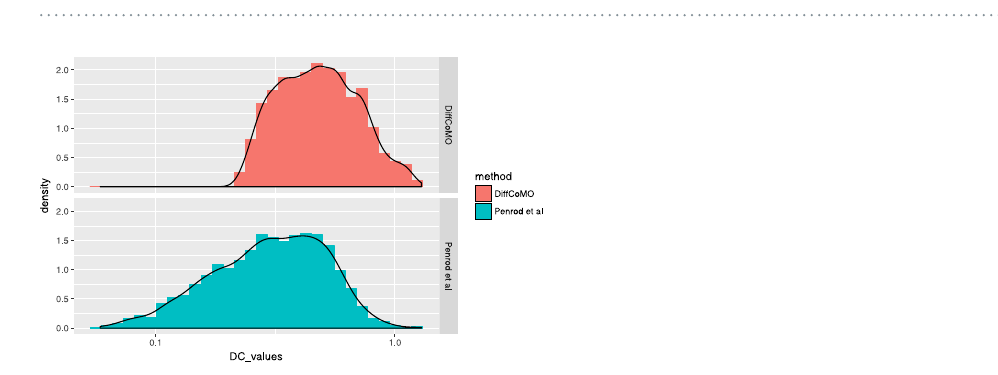
Figure 6. Distribution of DC _ Score - the left pane show the fraction of identified modules having DC_Score score above 0.35, while the right pane show the distribution of DC _ Score for DiffCoex, CoXpress, CLICK and the proposed DiffCoMO algorithm.